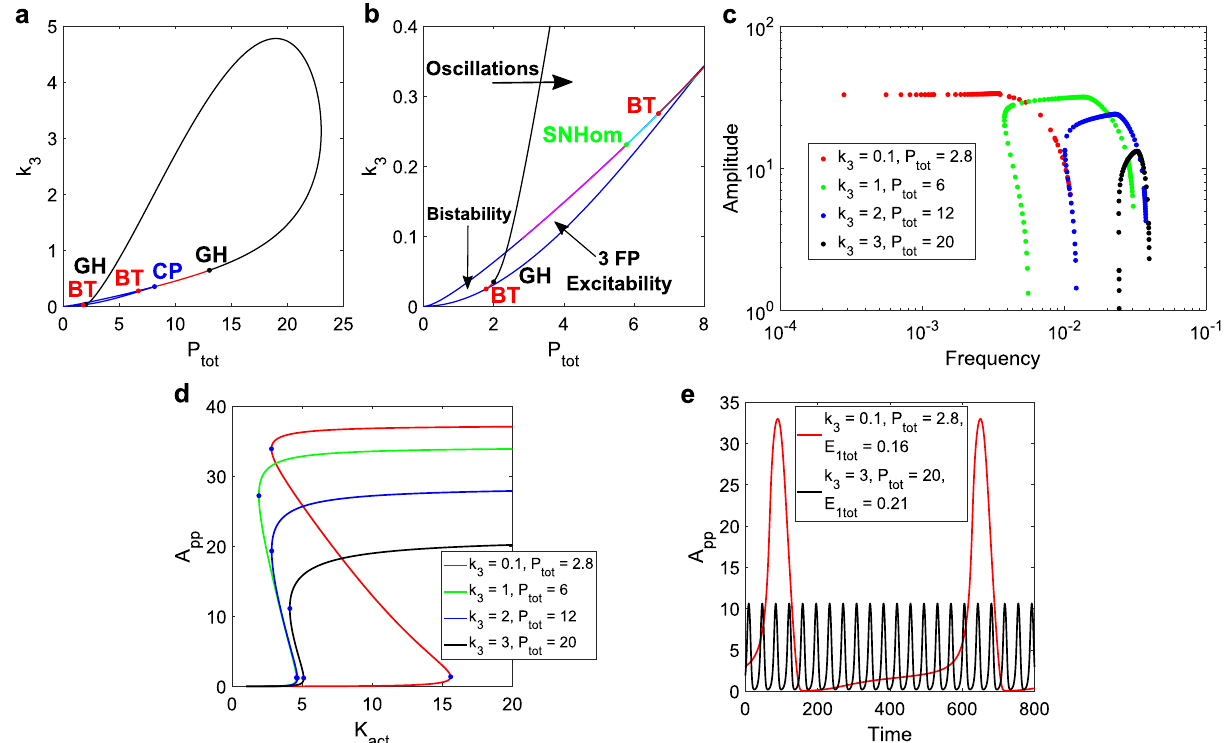
Figure 6. Results for the k 3 vs P tot analysis in the 1 + 2 model. ( a ) 2D bifurcation diagram for the two parameters. In black, the supercritical Hopf curve. In red, the subcritical one. In blue, the SN curves with the CP at the joint. GH bifurcations in black. BT bifurcations in red. The oscillatory region is considerably larger than for the SK model. ( b ) Zoom of the 2D diagram, showing the different regions and the global bifurcations. Like in the SK model, a bistable region develops for low values of k 3 and low values of P tot . The Saddle-Node on Invariant Circle (SNIC) curve is in magenta, following the path of one of the SN curves. This SNIC curve connects to a relatively small SHom curve via a SNHom point. Then the SHom curve (in cyan) connects to the Hopf curve via the BT bifurcation. ( c ) Amplitude vs. frequency curves for four different pairs of k 3 and P tot , scanning the parameter E 1tot . There is more flexibility in the transition of these curves when compared to the SK model. A SNIC bifurcation allows the frequency to be significantly lowered for the pair closest to the bistable region. Supercritical Hopf bifurcations allow the amplitude to reach lower values in the other branches of the curves, although the scan of the input becomes more precise close to the bifurcations as the system moves to the lower left of the 2D diagram. ( d ) DP bistable curves while scanning K act for each pair selected, showing, as before, the increase in amplitude with lower P tot . ( e ) Time series for two extreme cases within the oscillatory